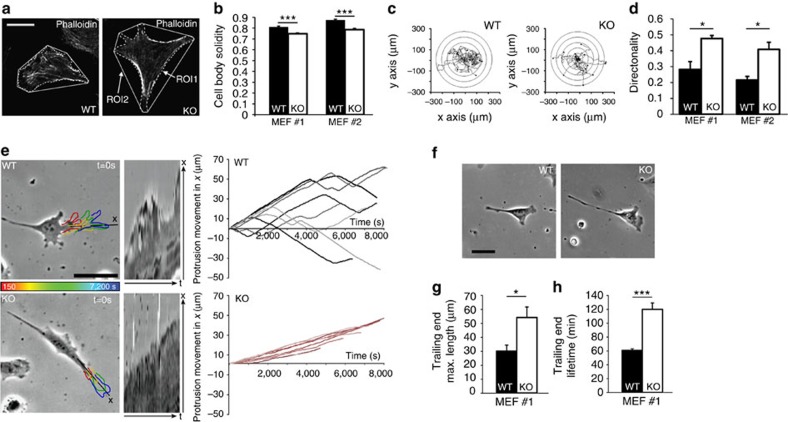
Loss of Stonin1 affects cell shape and motility.(a,b) Cell shape is altered in Stonin1−/− MEFs. (a) Solidity as measure for cell shape was calculated as cell body outline (ROI1) divided by convex hull (ROI2) using fixed Phalloidin-stained WT and Stonin1−/− MEFs. Scale bar, 25 μm. (b) Quantification of solidity in two pairs of WT and Stonin1−/− MEFs (N=3). (c,d) Increased directionality of Stonin−/− MEFs. Randomly migrating WT and Stonin1−/− MEFs were imaged for 12–16 h, and the tracks were analysed. (c) Radar plots (tracks centred to their origin at t0) of WT and Stonin1−/− cells. (d) Quantification of directionality (accumulated distance divided by Euclidean distance) for two pairs of WT and Stonin1−/− MEFs (N=3, a minimum of two 12-h movies with a frame interval of 15 min and 30 cells were analysed per experiment). (e) Stonin1−/− MEFs exhibit more stable protrusions. Left: representative images of WT and Stonin1−/− MEFs together with kymographs along the indicated line x and the length of the movie (t=120 min with 150-s intervals); protrusion perimeters in 30-min intervals indicated in temporal colour code. Scale bar, 15 μm. Right: protrusion movement extracted from kymographs for WT and Stonin1−/− MEFs (n=8). (f–h) Increased trailing end length and lifetime in Stonin1−/− MEFs. Representative images (f) and quantification of maximum trailing end length before rear detachment (g) and lifetime (h) based on random migration movies (N=3, n=94–98). Scale bar, 25 μm. All data are depicted as mean±s.e.m. and compared by unpaired two-tailed Student's t-tests, ***P<0.001, *P<0.05.